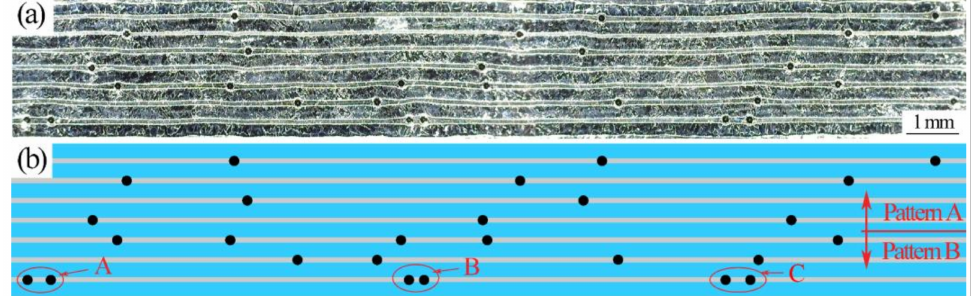
Figure 7. Transverse section of SiC f -reinforced Ti/Ti–Al laminated composites: ( a ) Optical microscopy (OM) image; ( b ) structure illustration.